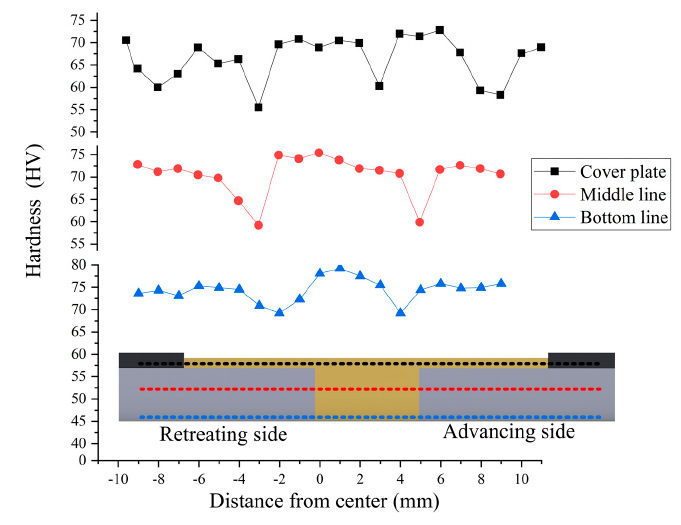
Figure 9. Microhardness of the joint.